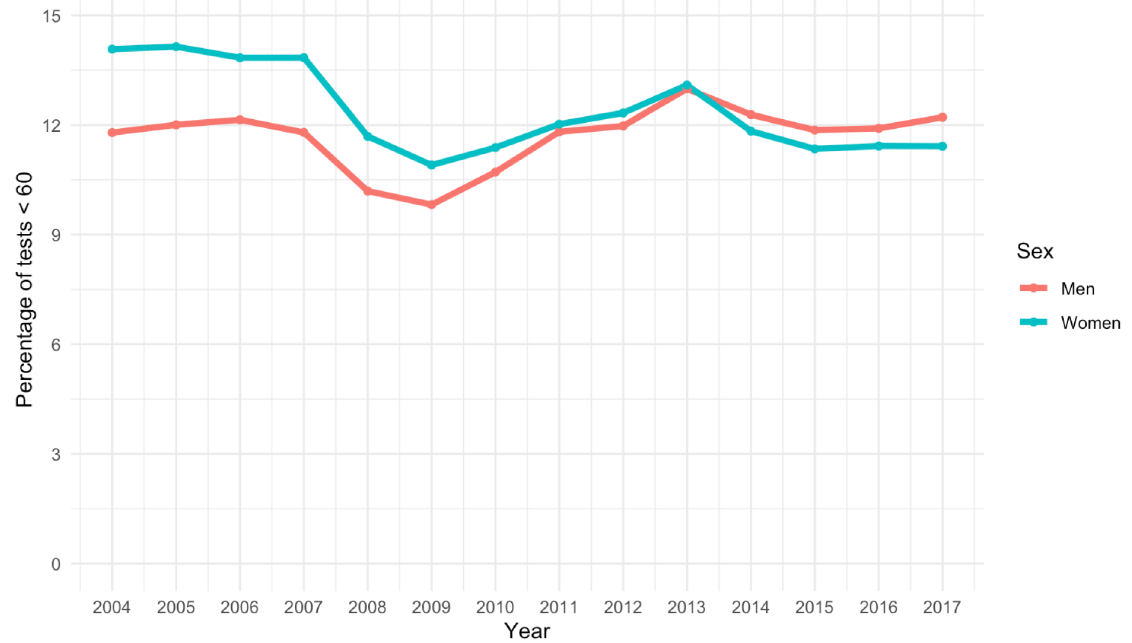
variation by age, gender and geography. Annual incidence is approximately 1.0%, with prevalence at 6.5% using international definitions